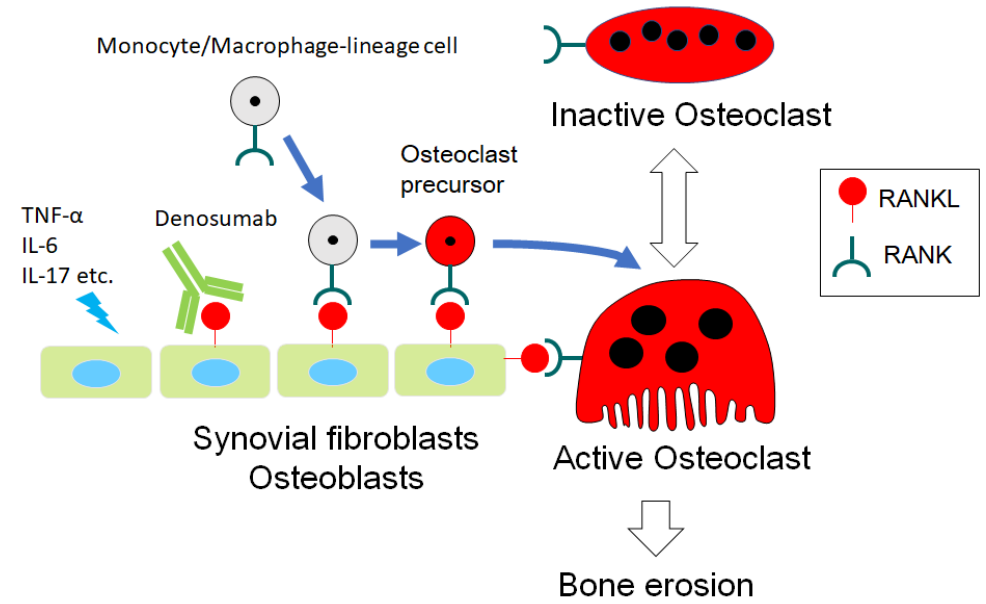
Figure 3. Schematic representation of the mechanism for osteoclast development and denosumab action in rheumatoid arthritis. Pro-inflammatory cytokines such as tumor necrosis factor-alpha (TNF- α ), interleukin-6 (IL-6), and IL-17 directly or indirectly induce receptor activator of nuclear factor-kappa B ligand (RANKL) expression in synovial fibroblasts or osteoblasts or both. RANKL stimulates osteoclast differentiation from monocyte/macrophage-lineage precursor cells, leading to bone erosion in rheumatoid arthritis. Denosumab specifically binds to RANKL and suppresses osteoclast